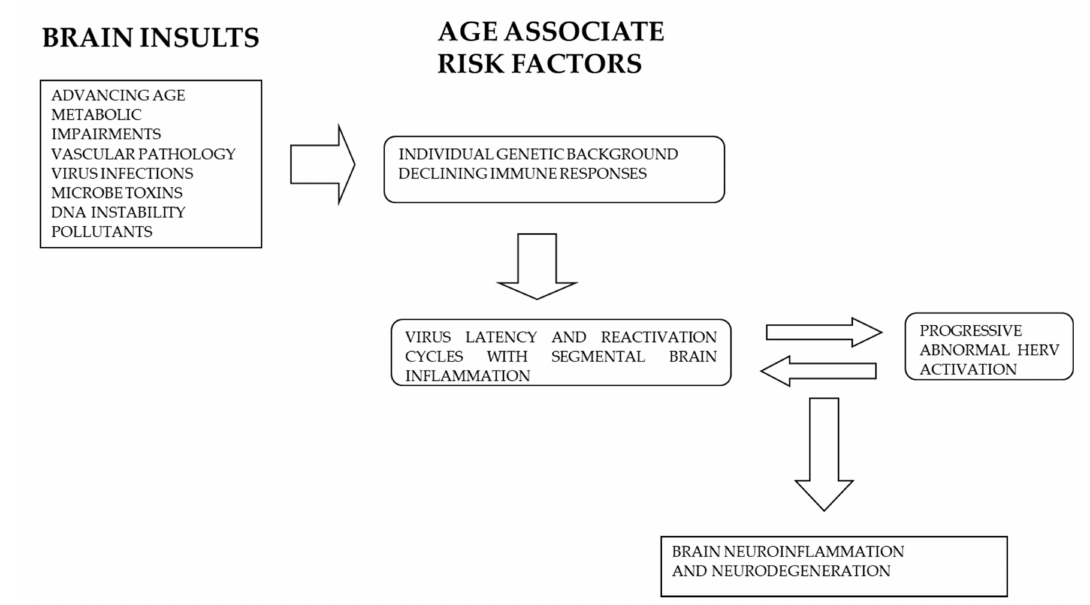
Figure 2. Different age-related risk factors contribute to the interplay between exogenous virus infections and HERV abnormal activation leading to neuro-degenerative processes and